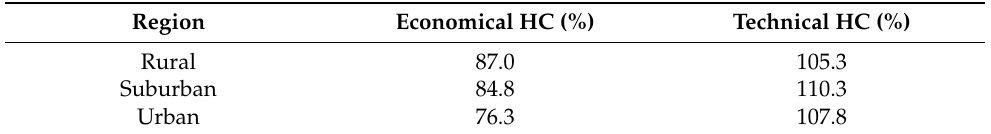
Table 8. The comparison between technical and economical HC values by using secondary trans- former rating as the reference value for